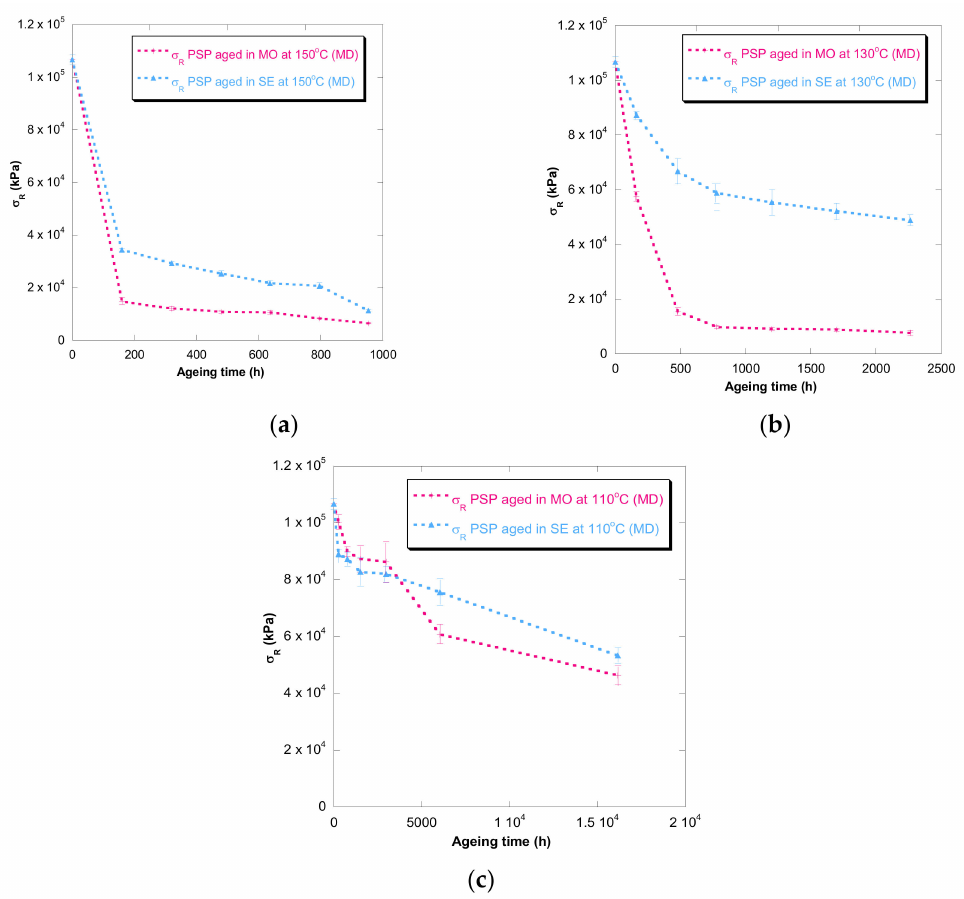
Figure 2. Evolution of the σ R in MD as a function of temperature for cellulose-board PSP 3055 aged in mineral oil and in synthetic ester at 150 ◦ C ( a ), 130 ◦ C ( b ), and 110 ◦ C ( c ).